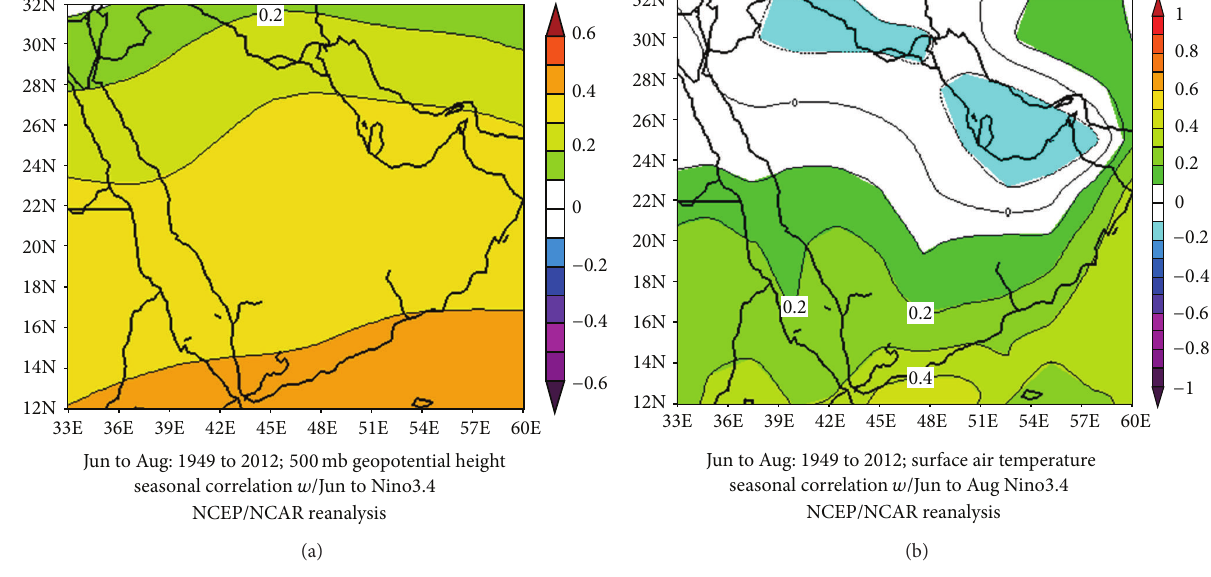
Figure 5: The distribution of linear correlation coefficient between weather elements over KSA and El-Nino3.4 through the period of study.